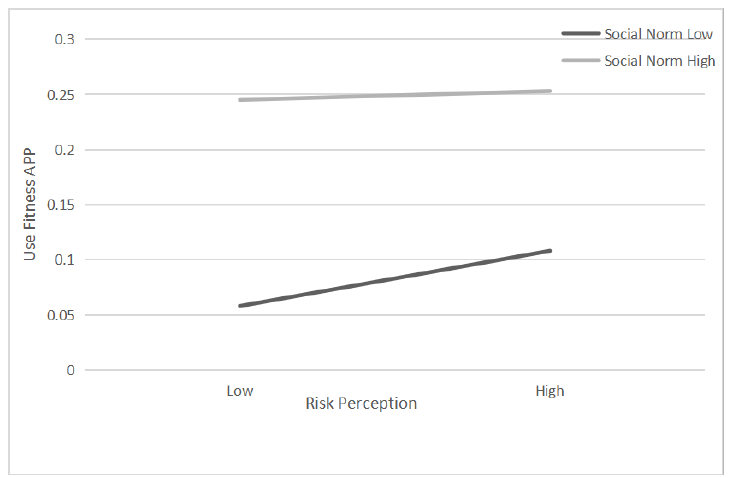
Figure 2. Social Norm as a function of the interaction between risk perception and use of sports